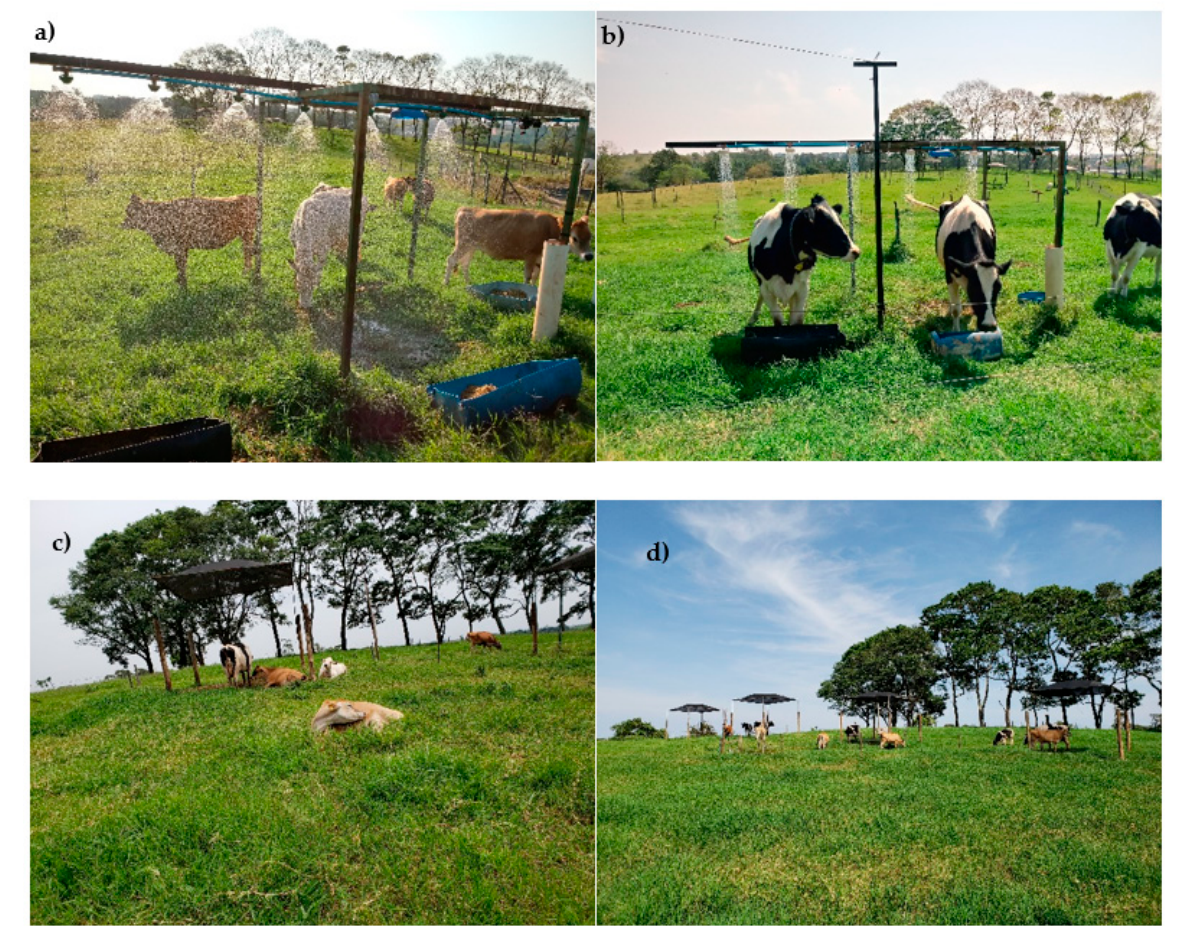
Figure 1. ( a ) Sprinkling + artificial shade; ( b ) showers + artificial shade; and ( c ) artificial shade. ( d ) All paddocks had the same artificial shading system at one end, comprising eucalyptus beams in which iron-based structures were fixed (3.5 m tall in total) with synthetic fabric (artificial shade) providing 80% solar retention. Source: Author